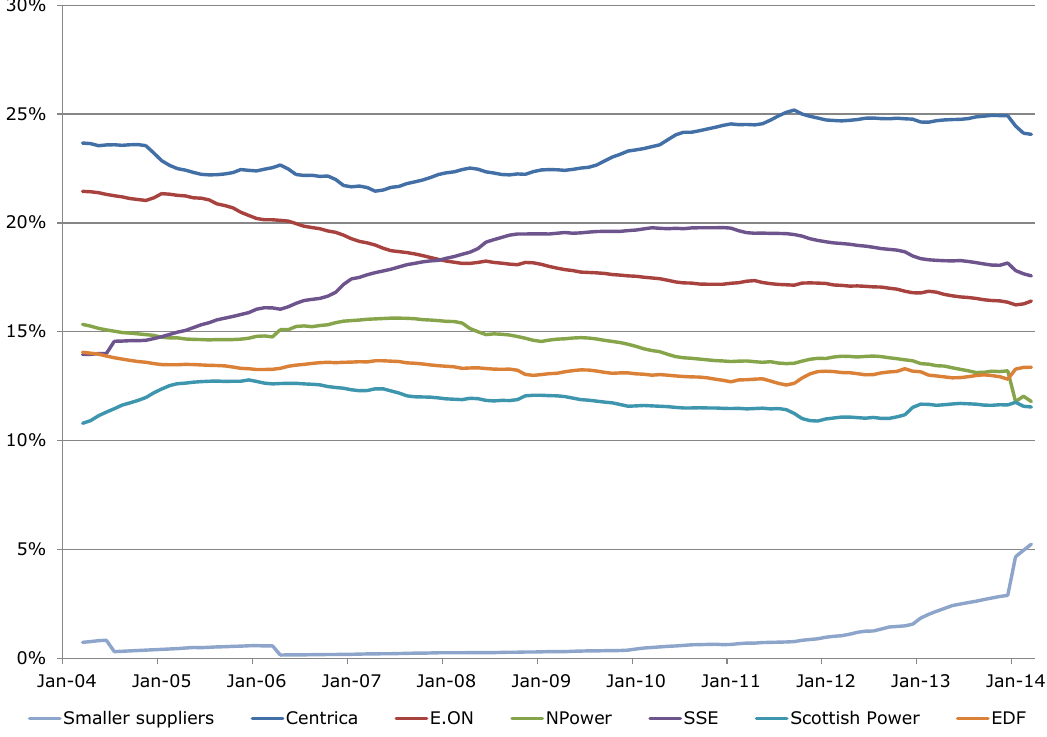
Figure 3: Domestic electricity supply market shares